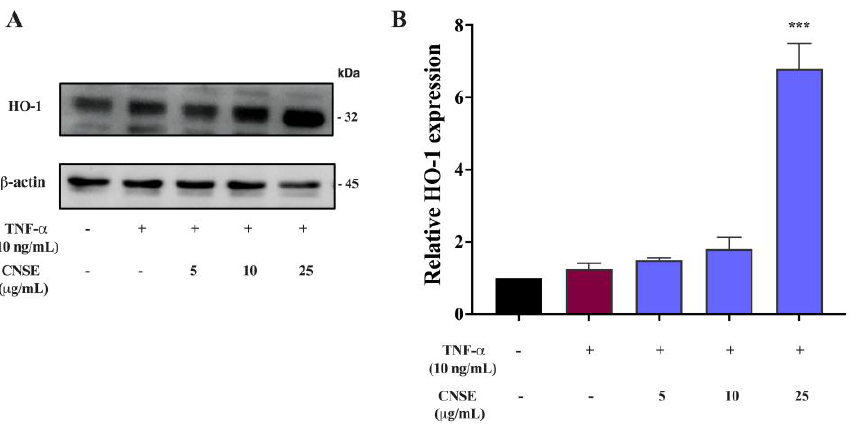
Figure 9. Effects of CNSE on HO-1 induction. BV-2 cells were preincubated with CNSE and then stimulated with TNF-α for 24 h. ( A ) The protein expression of HO-1 using Western blot analysis. ( B ) The histogram graph presents the relative expression of HO-1, which was quantified and normalized with β-actin. Black color represents untreated control, red color represents TNF-α group and violet color represents CNSE treatment. Data are represented as the mean ± SD from at least three independent experiments. A p -value < 0.05 was considered to show a significant difference between each group (*** p < 0.001 vs. TNF- 𝛼 -treated group).